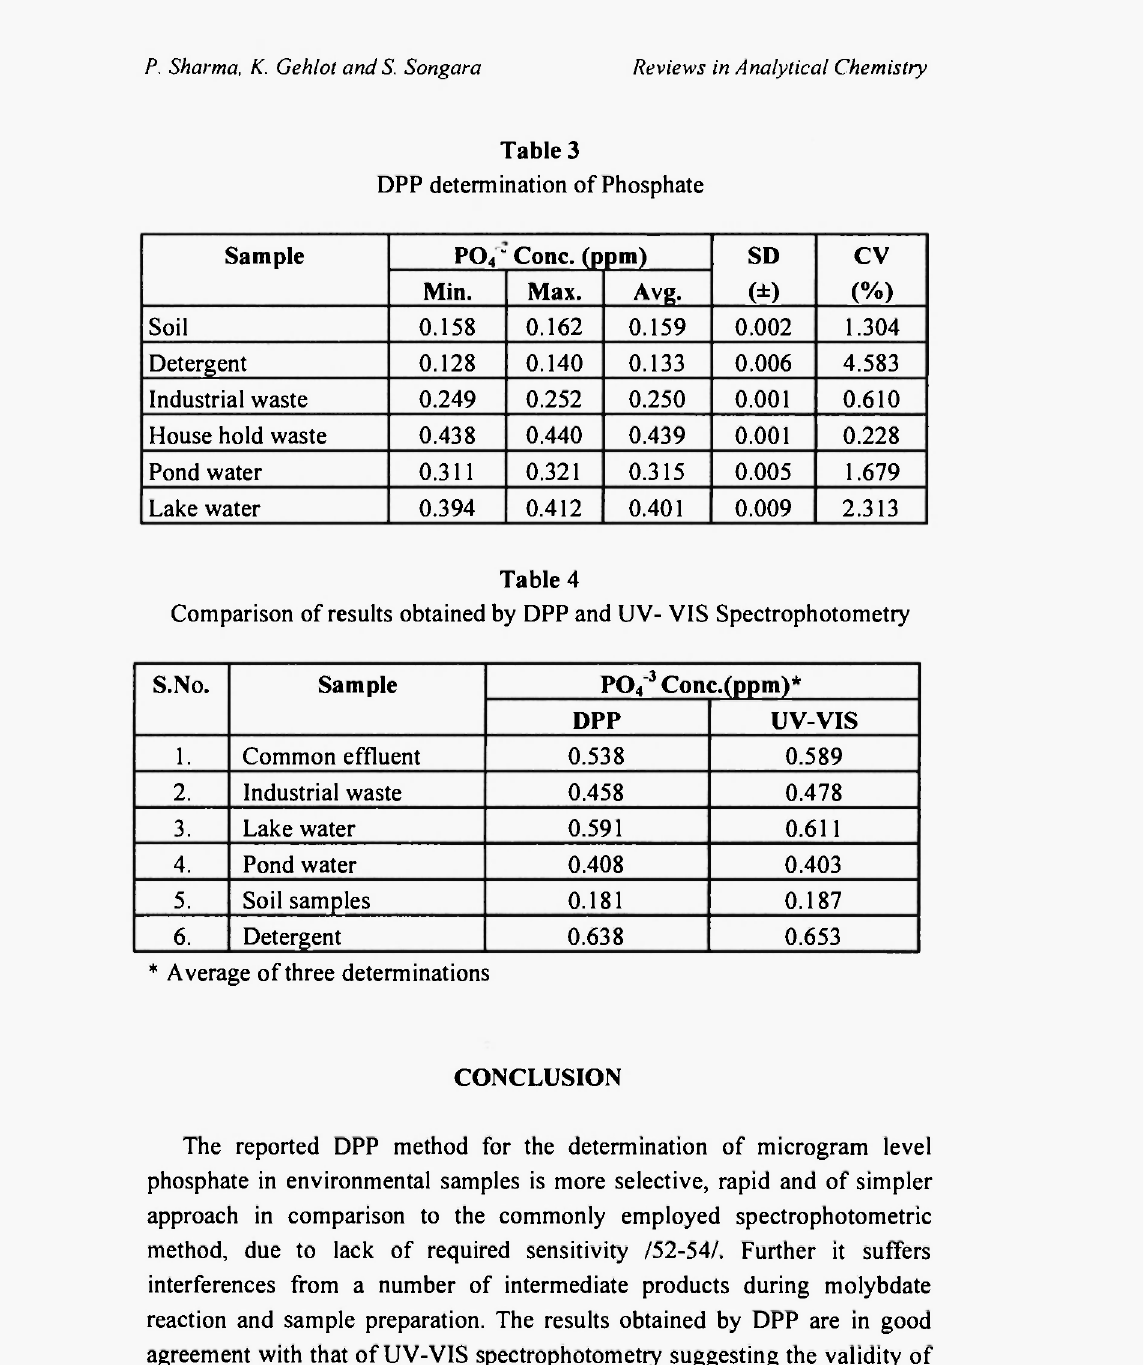
Comparison of results obtained by DPP and UV- VIS Spectrophotometry